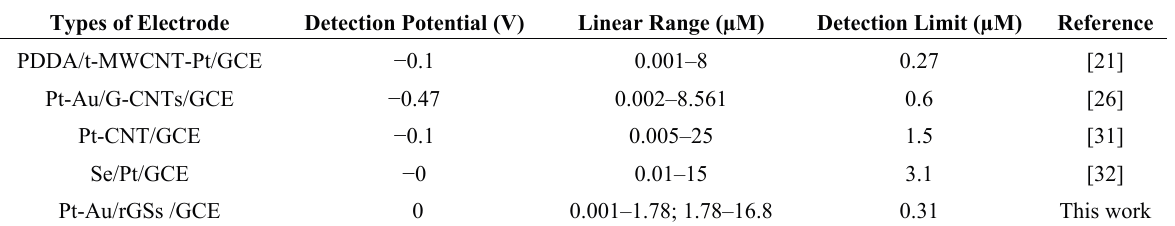
Figure 6. ( A ) Current-time response curve for successive injection of H 2 O 2 at Pt-Au/rGSs/GCE measured at 0 V. Inset: Magni fi ed image of the region in the rectangle; ( B ) Calibration curves of response current vs. H 2 O 2 concentration at Pt-Au/rGSs/GCE. Table 1. Comparisons of analytical performance of various H 2 O 2